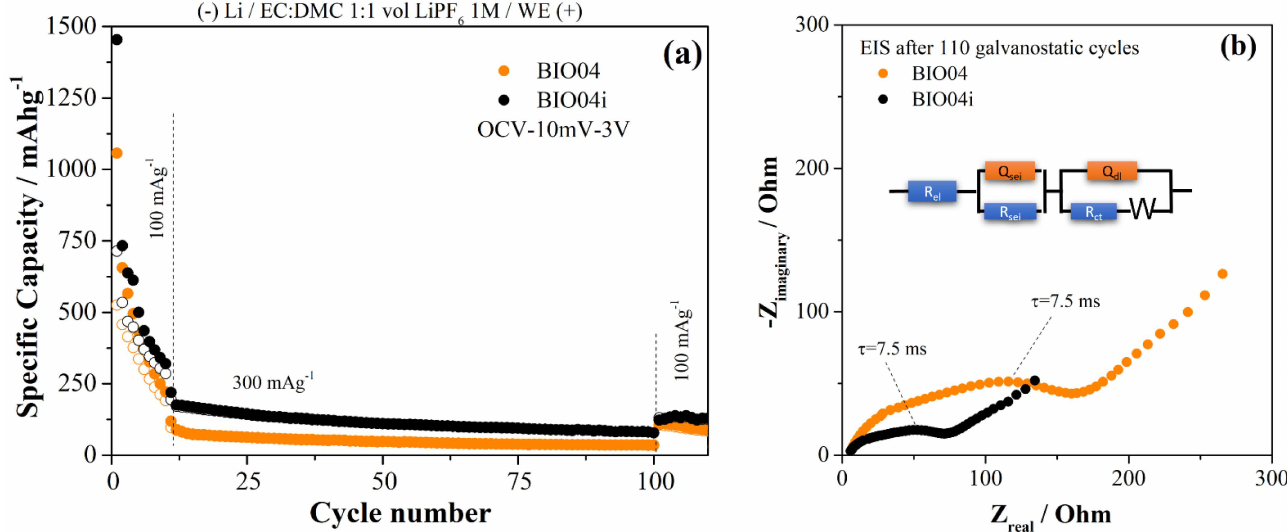
Figure 8. ( a ) comparison of the performance in galvanostatic tests of the BIO04 and BIO04i samples; ( b ) EIS spectra recorded on BIO04 and BIO04i electrodes after cycling and equivalent circuit adopted for modeling (BIO04: RSEI = 35 Ω ; RCT = 140 Ω ; QSEI = 1.1 µ F; QCT = 54 µ F; BIO04I: RSEI = 22 Ω , RCT = 55 Ω ; QSEI = 1.8 µ F; QCT = 140 µ